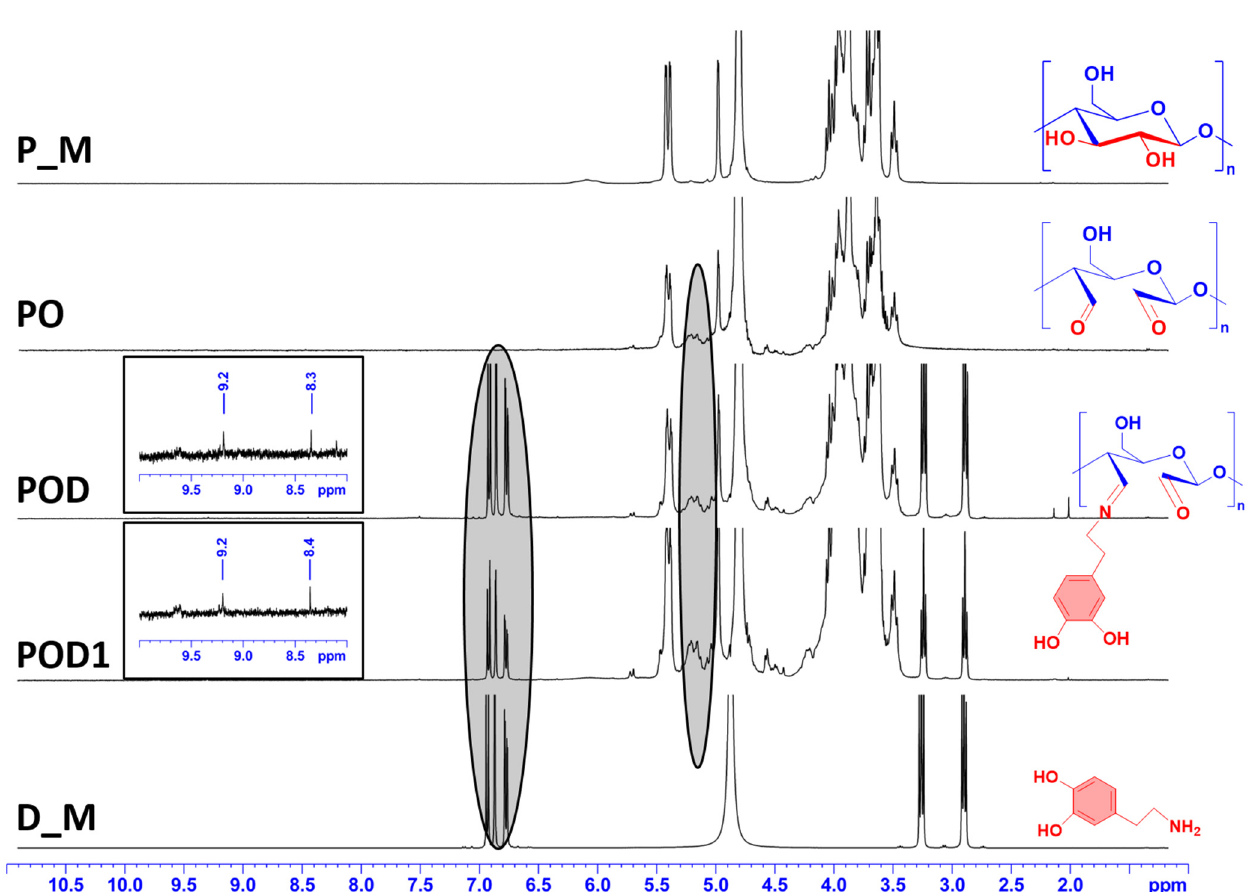
Figure 2. 1 H-NMR spectra recorded for pullulan, dopamine and the three types of cryogels. The pullulan spectrum (P_M) contains typical peaks for the polysaccharide structure.